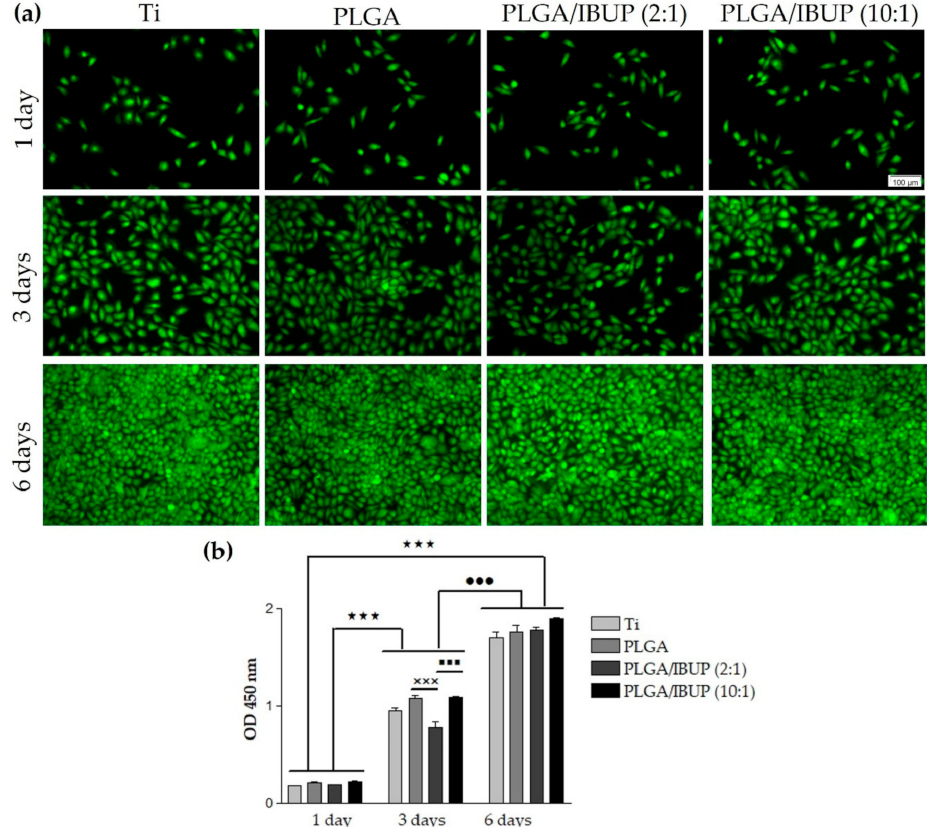
Figure 13. Viability and proliferation of human keratinocytes grown in contact with PLGA-based coatings for 1, 3 and 6 days, evaluated by: ( a ) viable cell fluorescent labeling (Live/Dead assay), scale bar 100 µ m; ( b ) keratinocyte proliferative (cid:70)(cid:70)(cid:70) p potential (CCK-8 test); < 0.001 vs. 1-day time point; ••• p < 0.001 vs. 3-day time point; ××× p < 0.001 vs. PLGA; (cid:4)(cid:4)(cid:4) p < 0.001 vs. PLGA/IBUP